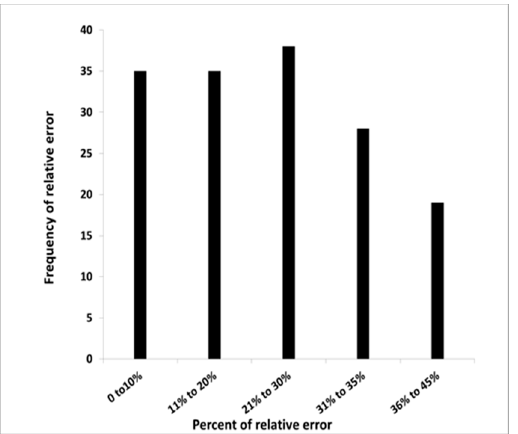
Figure 9. The frequency of relative error of modeled salinization concentrations with respect to observed concentrations. The total number of observations is 155.